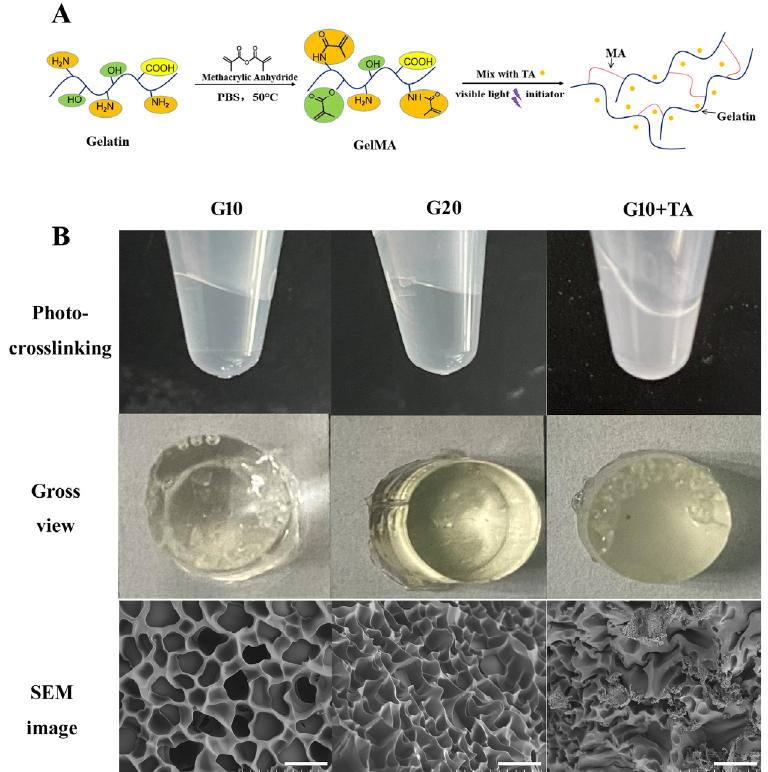
Figure 1. Fabrication and observation of gelatin methacrylate (GelMA) hydrogels at 10% and 20% GelMA, and 10% GelMA with 1 mg/50 μ L TA. ( A ) Schematic route of the synthesis of GelMA + TA hydrogel. ( B ) Gross comparison of hydrogel formation and SEM images of hydrogels prepared at various GelMA: TA ratios. Scale bar: 25 μ m.